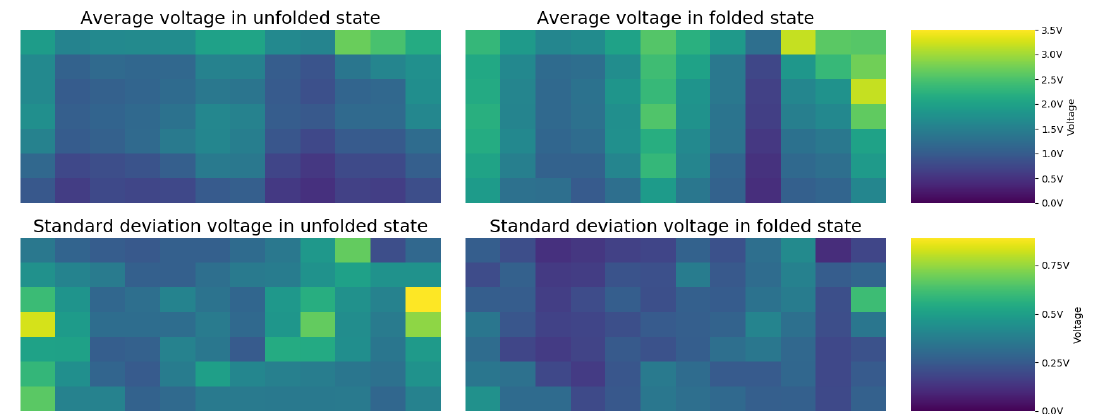
Figure 5. The average and standard deviation of the collected data from the 12 by 7 tactile cells show a higher voltage in the center column—where the fold is—when the cloth is in the folded state. These figures qualitatively indicate that the tactile cells in the textile react to different folding configurations.